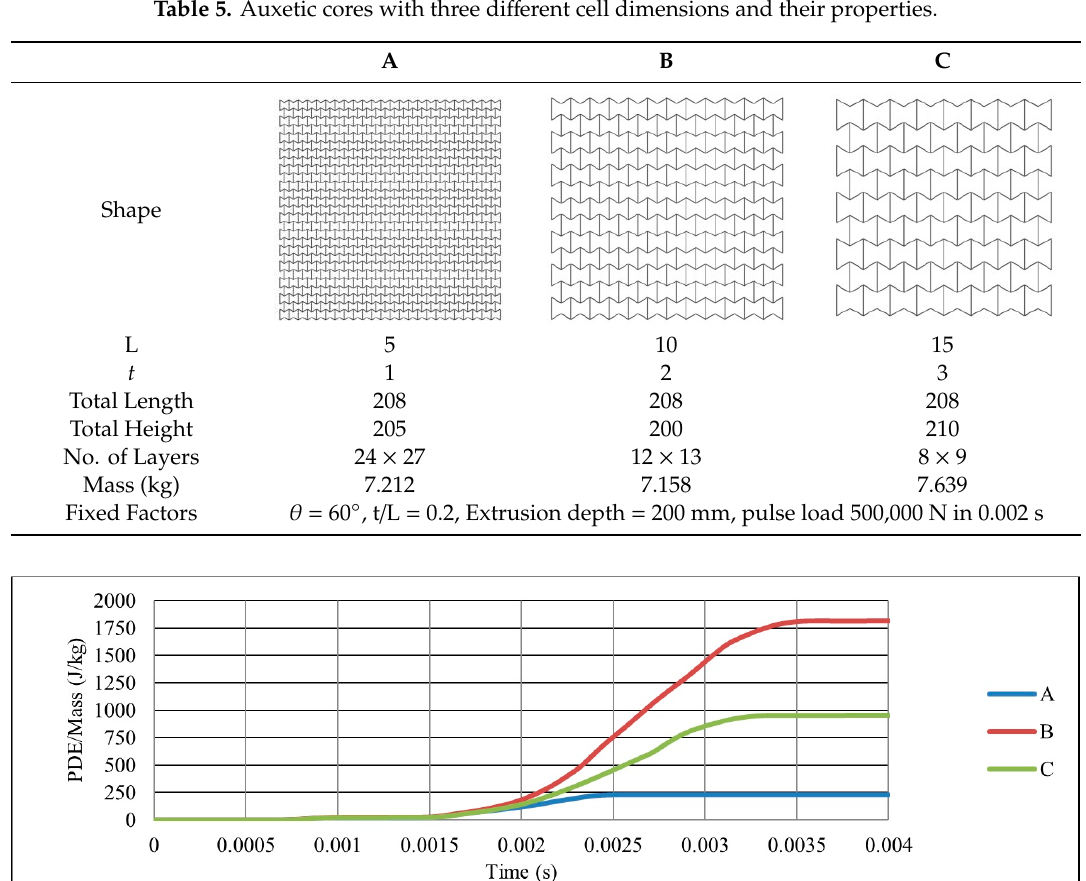
Table 5. Auxetic cores with three different cell dimensions and their properties.